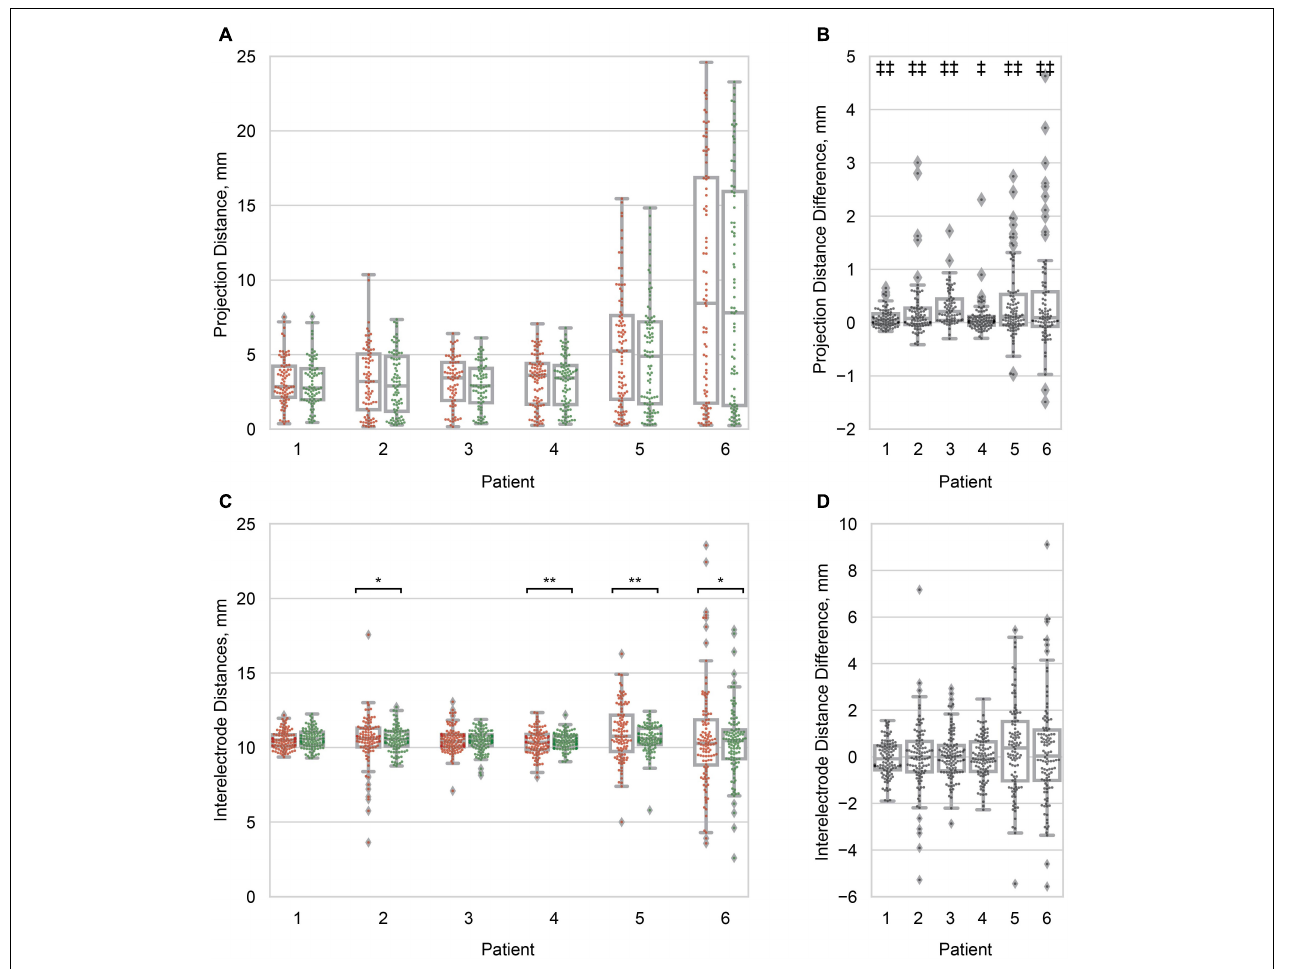
FIGURE 4 | Projection and inter-electrode distances. (A) Boxplots of the principal axis (red/ left ) and Hermes (green/ right ) projection distance for all electrodes within a patient. Distribution variances were not significantly different between projection methods ( α = 0.05). Patients are ordered from least to greatest median Hermes projection distance. (B) Boxplots of the pairwise projection distance difference: principal axis–Hermes. In all patients the projection distance was significantly smaller for the Hermes method. (C) Boxplots of the inter-electrode distances for the principal axis (red/ left ) and Hermes (green/ right ) projection methods. Each data point represents a pair of neighboring electrodes on the ECoG grid. The inter-electrode variance was statistically less for the Hermes method for patients 2, 4, 5, and 6. (D) Paired inter-electrode distance differences (principal axis–Hermes) were not statistically significant ( α = 0.05). For (A,C) , significantly different variances between the principal axis and Hermes methods are denoted with * p < 0.01; ** p < 0.001. For (B,D) , significantly different paired distances are denoted with ‡ p < 0.01; ‡‡ p < 0.001. All distances are for the 0 mm CSF models.